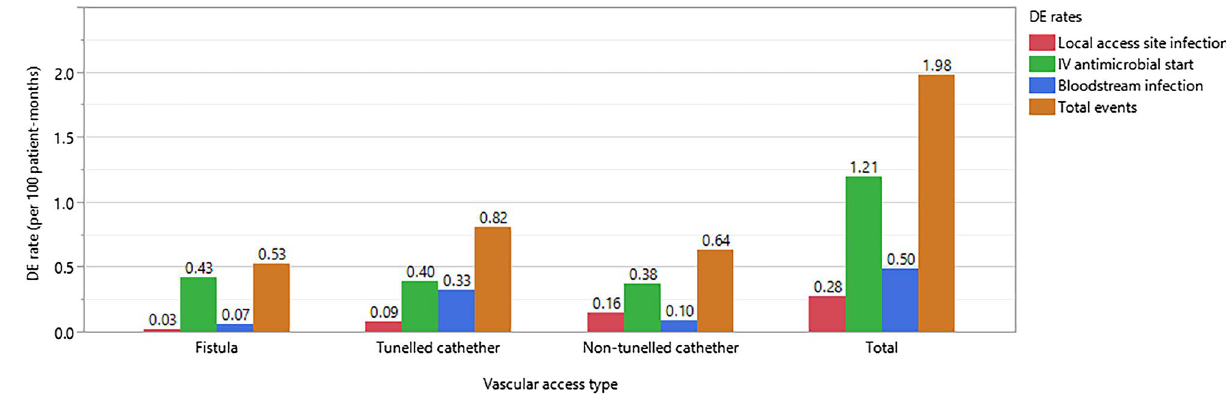
Figure 1. DE rates for each vascular access type.